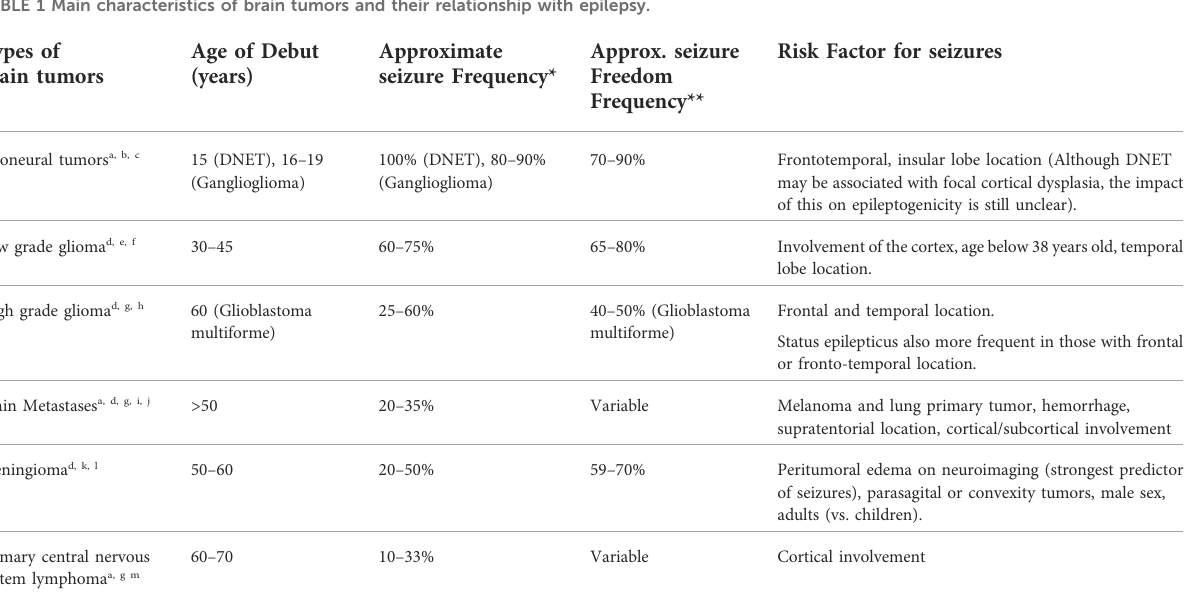
TABLE 1 Main characteristics of brain tumors and their relationship with